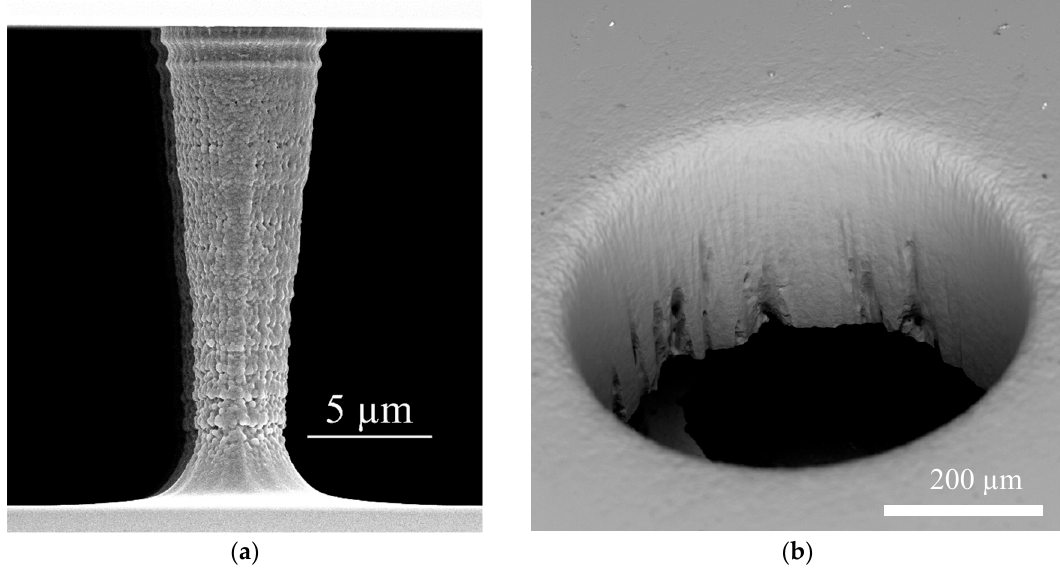
Figure 4. Scanning electron micrographs showing the post arrays and fluidic connections. ( a ) Detailed view of the micropost array showing the tapered profile. ( b ) Via for fluidic connections created by fs-laser induced plasma cutting.